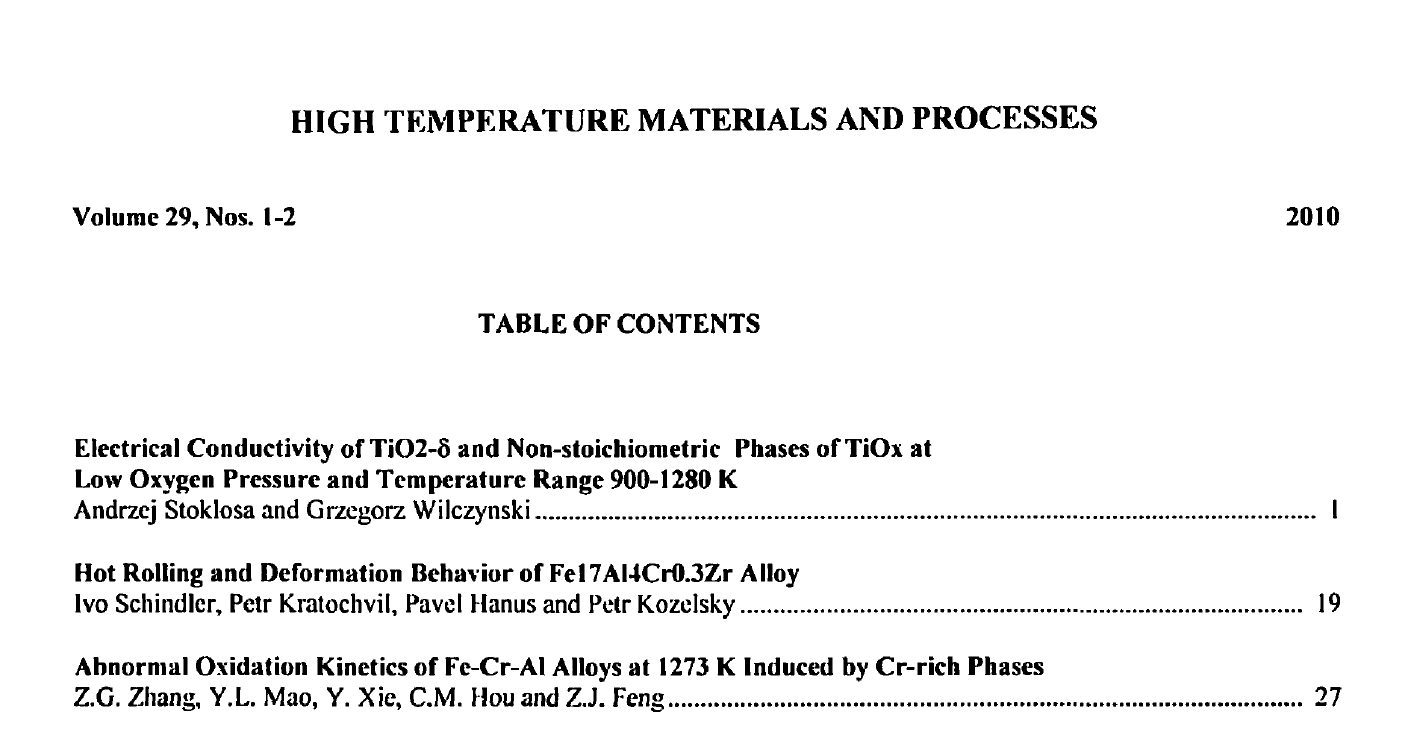
Electrical Conductivity of Ti()2-o and Non-stoichiometric Phases of TiOx at Low Oxygen Pressure and Temperature Range 900-1280 K Andrzej Stoklosa and Grzegorz